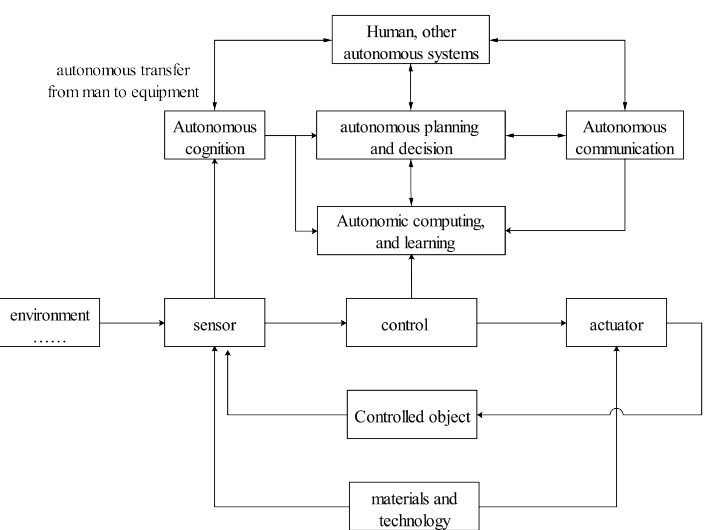
Figure 7. Extension from classical automatic system to autonomous system. At present, the military field [57] is the most widely used field of unmanned systems, and it is also the field closest to the application of the autonomous system. DARPA, together with ABC and Hopkins University, studied the standard operating system (COS) of the joint unmanned air combat system [58]. Different types of UAV (Unmanned Aerial Vehicle), UAV ground control station, and communication satellite are integrated into an organic whole, which can effectively share information among members and make planning and decision at the system level and platform level, resulting in the networked operation between multiple platforms. The system framework is shown in Figure 8.